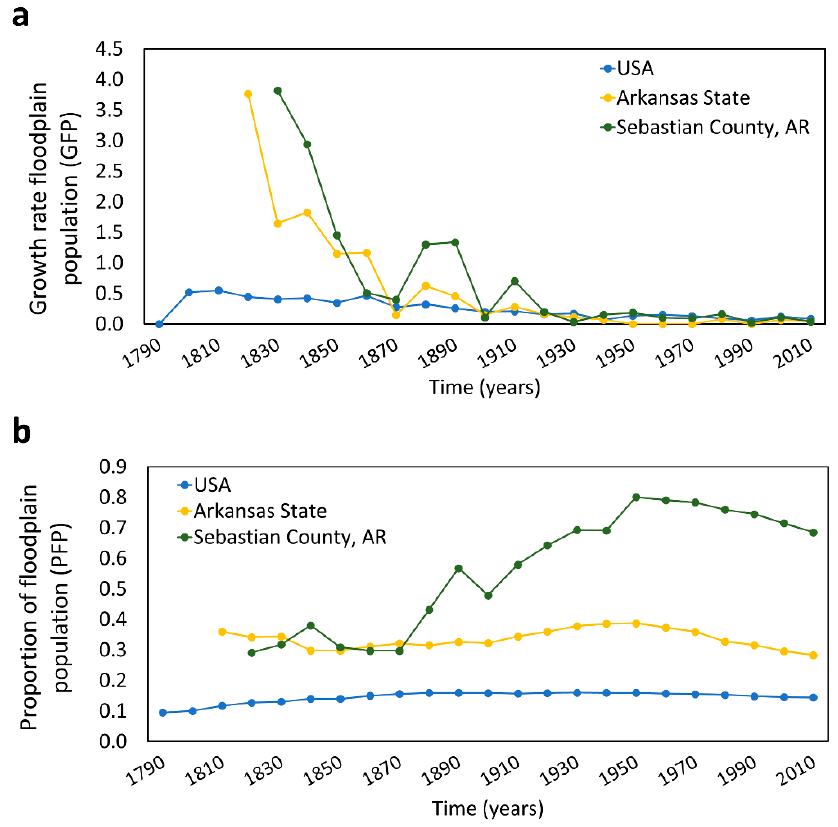
Figure 8. ( a ) Growth rate of floodplain population ( GFP ) and ( b ) proportion of floodplain population (PFP) observed at the three different spatial scales (national, state, and county levels) proposed in this study.